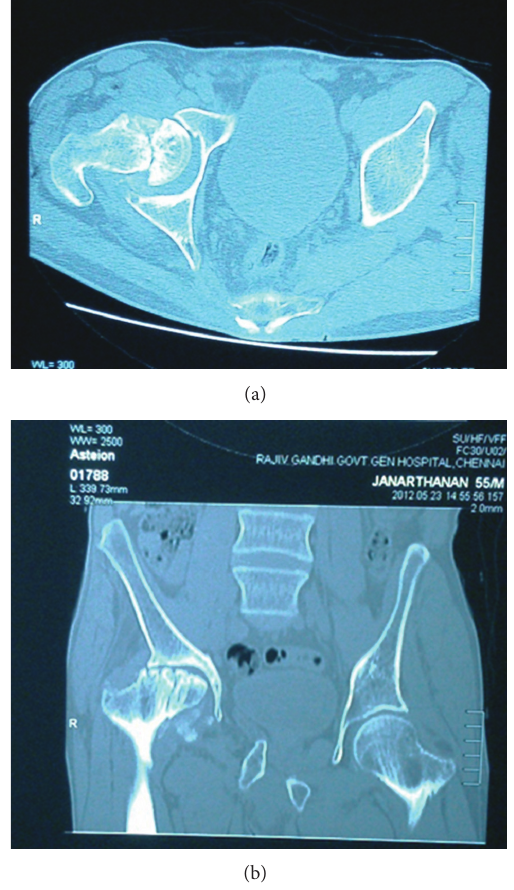
F 2: CT images revealing fracture of head of femur.